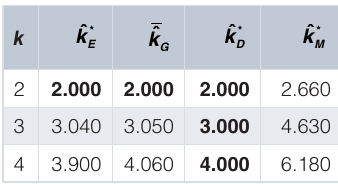
Table 12. Average error size (when wrong) over n = 200